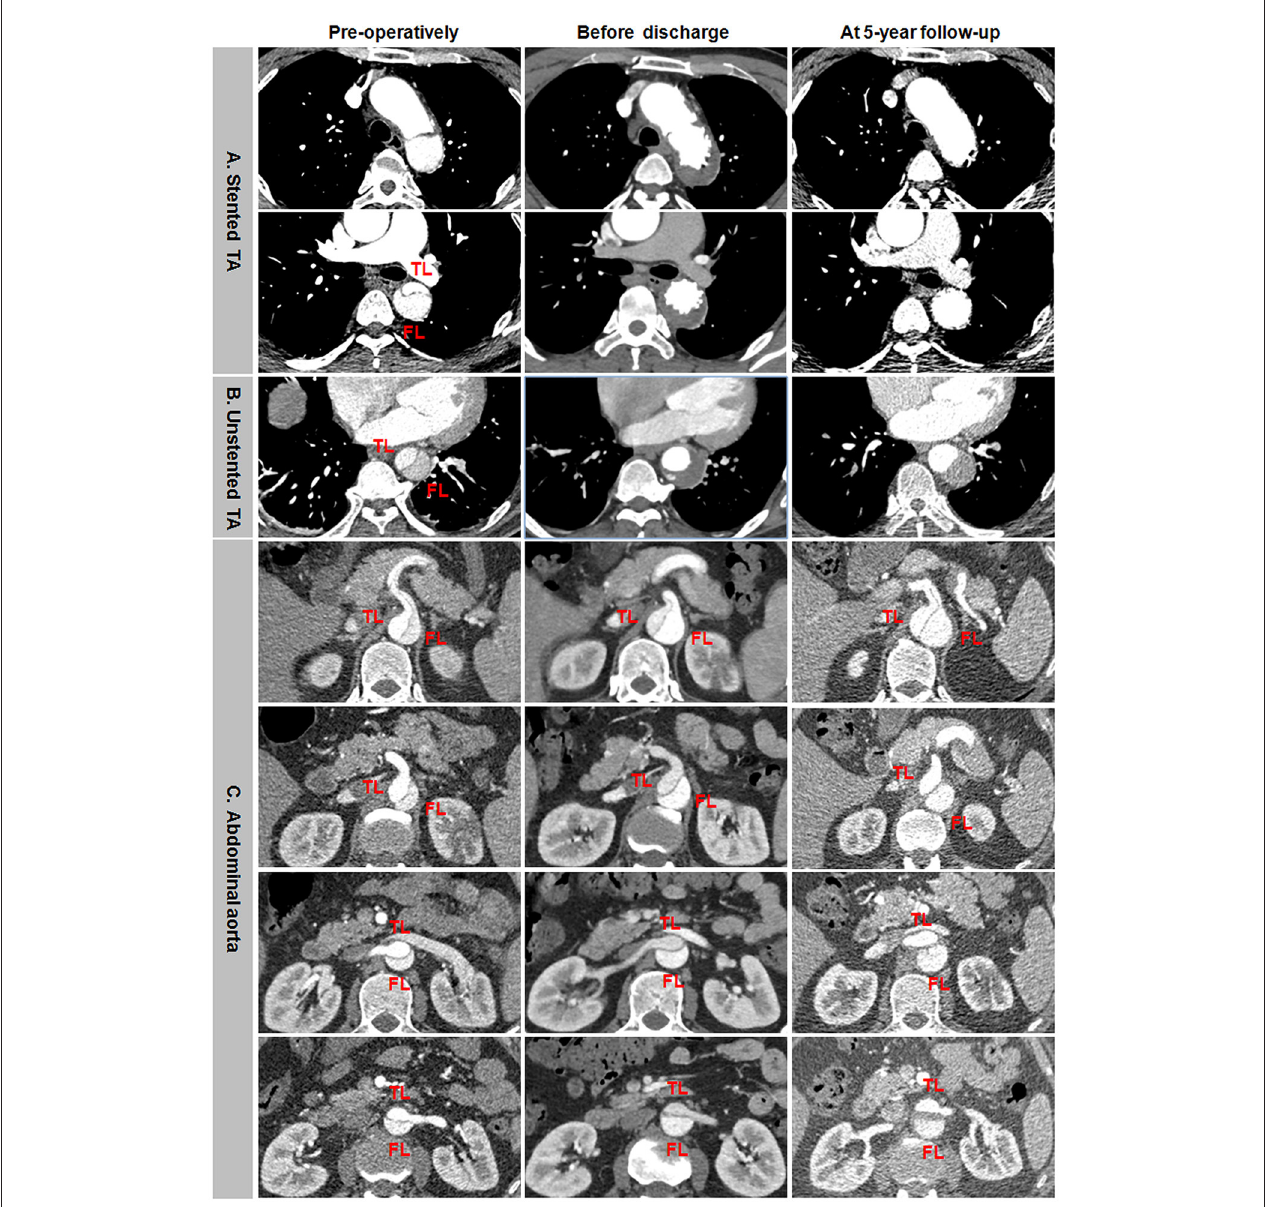
FIGURE 5 | Differential remodeling patterns between the thoracic and abdominal aorta after TEVAR for TBAD. (A) FL was entirely thrombosed immediately after TEVAR, and the absorption of FL thrombosis and the enlargement of TL occurred on the stented thoracic aorta in 5 years post-operatively. (B) FL was thrombosed immediately after TEVAR, and the progressive dilation of thrombosed FL was on the unstented thoracic aorta in 5 years after TEVAR. (C) FL remained patent, and TL was relatively stabilized immediately after TEVAR, an obvious enlargement of patency FL and the resultant transaortic expansion occurred on the abdominal aorta in 5 years after TEVAR. TBAD, type B aortic dissection; TEVAR, thoracic endovascular aortic repair; FL, false lumen; TL, true lumen.